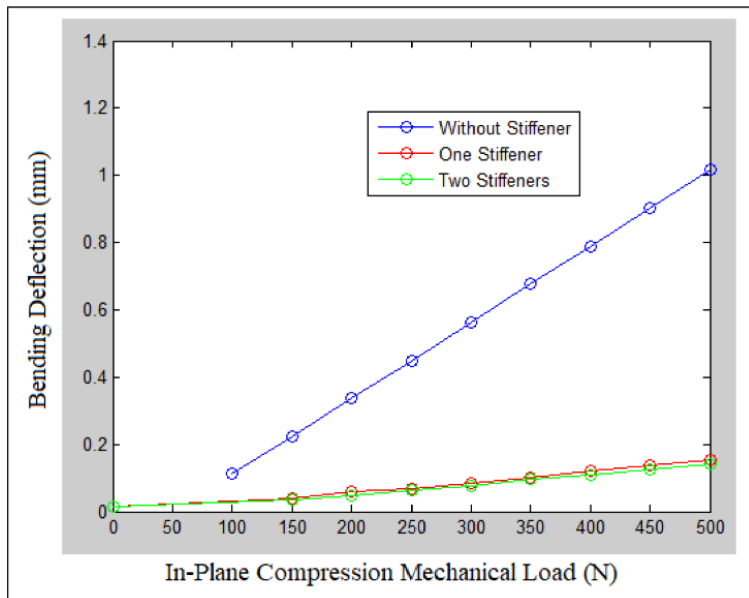
Figure 7. Buckling